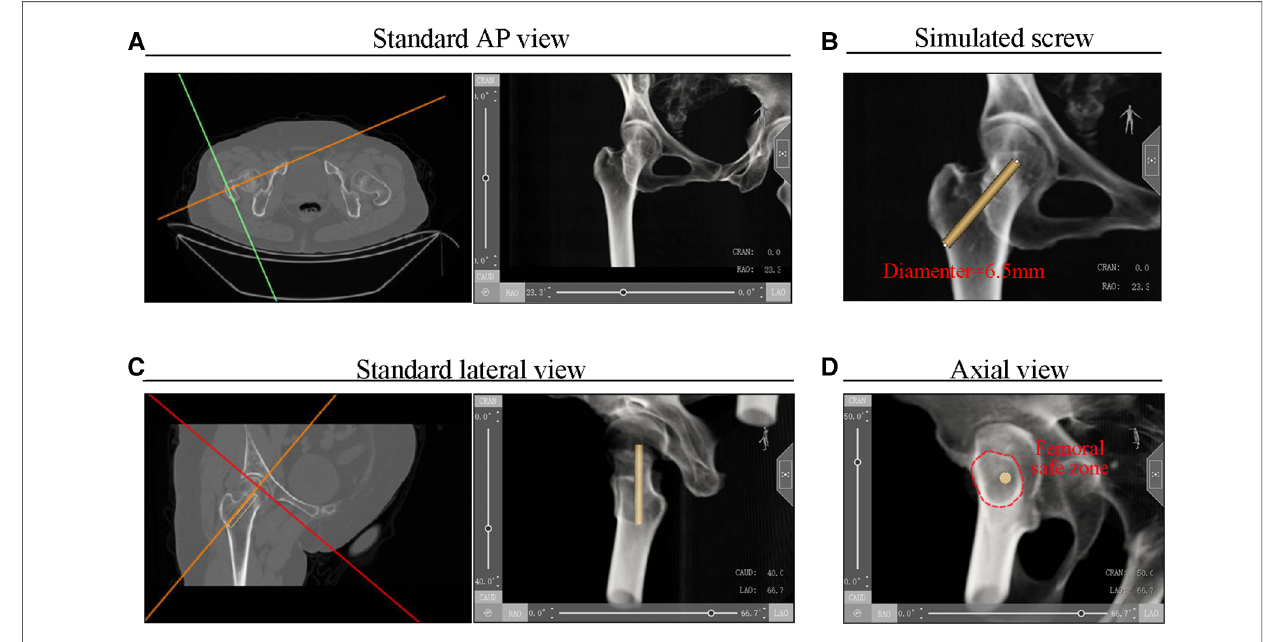
FIGURE 1 Simulated ( A ) AP, ( B ) lateral, and ( C ) axial views of the